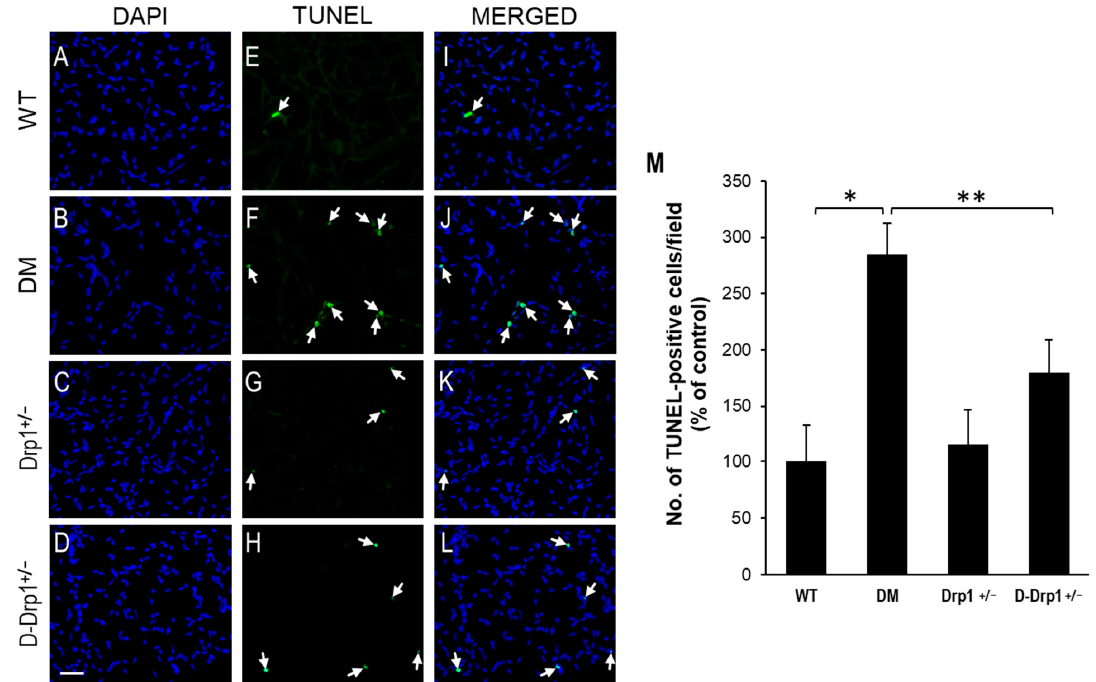
Figure 5. Reduced Drp1 level protects against diabetes ‐ induced apoptosis of vascular cells in retinal capillary networks. Representative images of capillary networks showing DAPI ‐ stained cells in the ( A ) WT, ( B ) diabetic (DM), ( C ) Drp1 +/ − , and ( D ) diabetic Drp1 +/ − (D ‐ Drp1 +/ − ) mice. ( E – H ) Corresponding images of TUNEL ‐ positive cells (arrows) in the retinal capillary networks, respectively. ( I – L ) Merged images showing DAPI ‐ stained cells superimposed with TUNEL ‐ positive cells. Scale bar = 100 μ m. ( M) Graph of cumulative data showing that retinal capillary networks of diabetic mice exhibited an increase in number of TUNEL ‐ positive cells compared to that of WT mice, while retinal capillary networks of D ‐ Drp1 +/ − mice showed reduced number of TUNEL ‐ positive cells compared to that of diabetic mice. Data are presented as mean ± SD. * p < 0.01, n = 6; ** p < 0.05, n = 6.